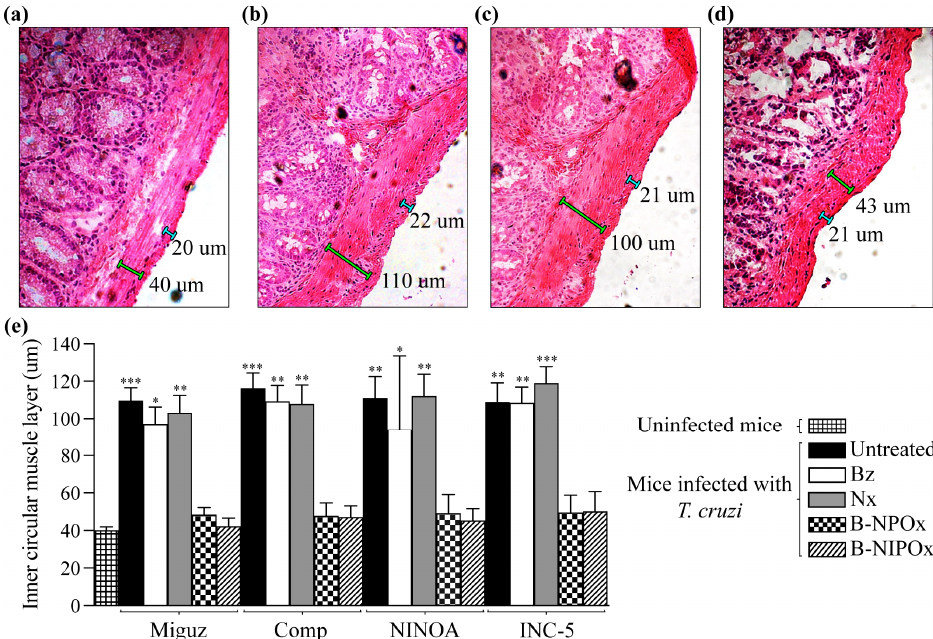
Figure 7. The benzyl ester of N-propyl oxamic acid (B-NPOx) and the benzyl ester of N-isopropyl oxamic acid (B-NIPOx) prevent the thickening of the intestinal inner circular muscle layer of mice